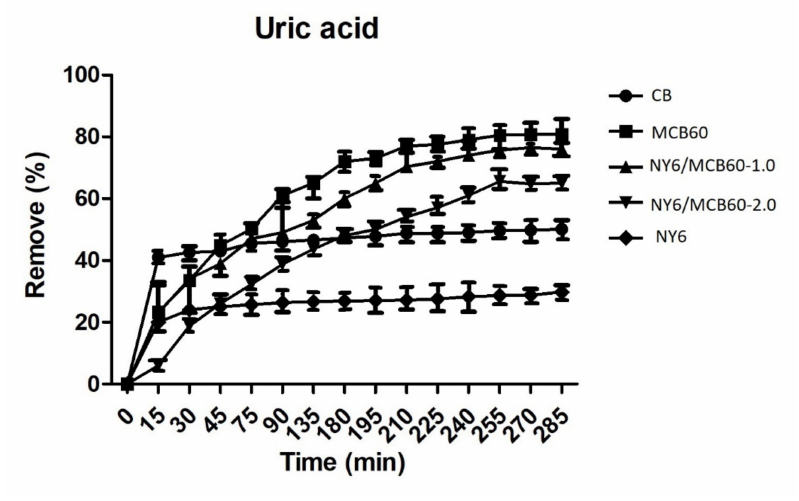
Figure 8. Removal percentage of uric acid of the Nylon 6, CB, and